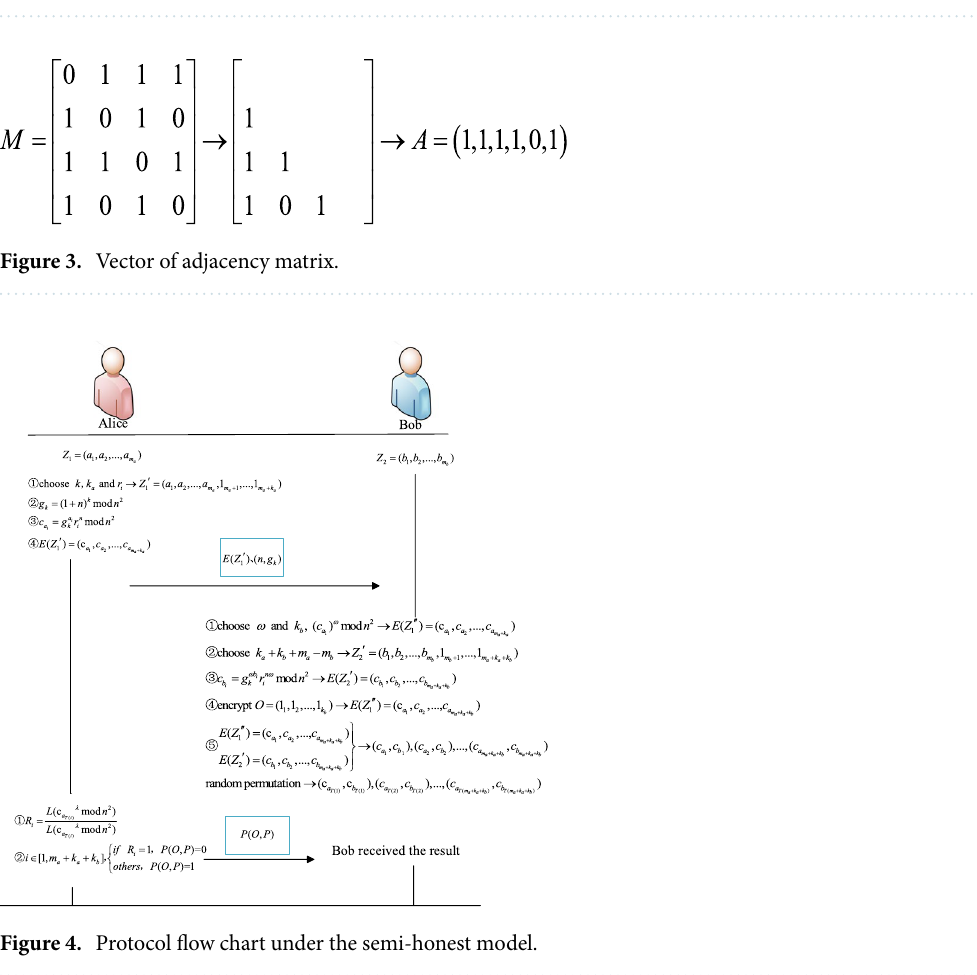
Figure 2. Matrix example.